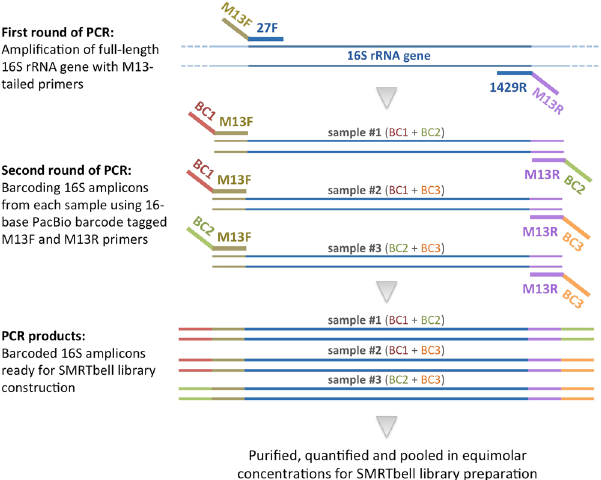
Figure 2. Two-step generation of 16S amplicons for PacBio sequencing using M13-tagged barcoded primers. The first round of PCR amplifies full-length 16S rRNA fragments using gene-specific primers tailed with universal M13 forward or reverse sequence. In the second step, a unique combination of barcode sequences is added to 16S amplicons from each sample using M13 forward and reverse primers tagged with 16-base PacBio barcodes at their 5 ′ ends. Barcoded amplicons are subsequently pooled for SMRTbell library construction and multiplexed